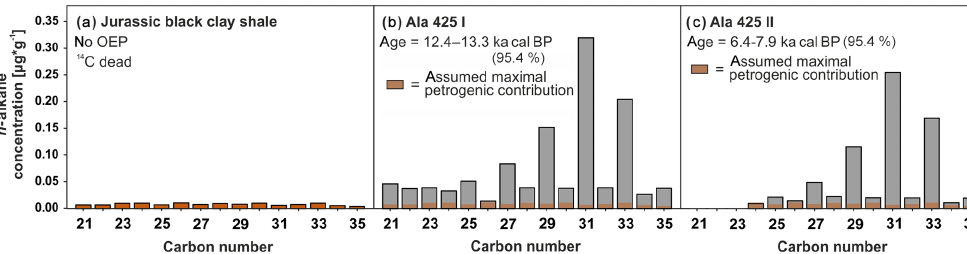
Figure 4. n -Alkane chain-length distributions in µgg − 1 sediment for (a) a Jurassic black clay shale sample from the upper Alazani subcatch- ment, (b) FSPS sediment sample Ala 425 I without heating and (c) re-extracted FSPS sediment sample Ala 425 II after heating with 120 ◦ C for 8h. n -Alkane 14 C ages for samples Ala 425 I and II are given as age ranges in kacalBP (95.4%).